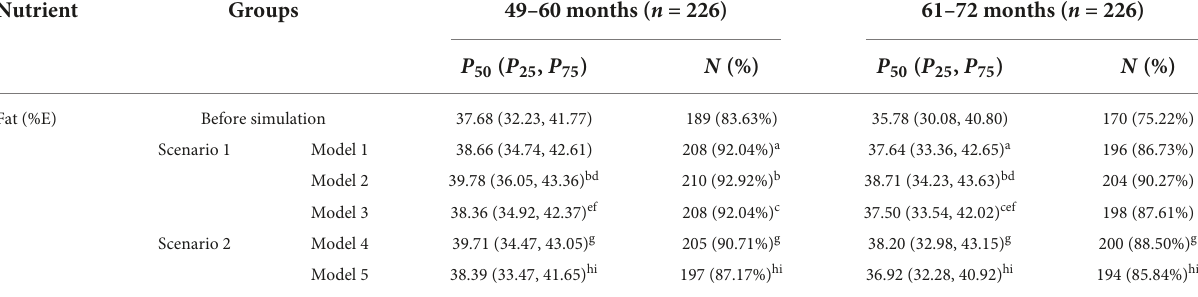
TABLE 4 Energy contribution from fat after